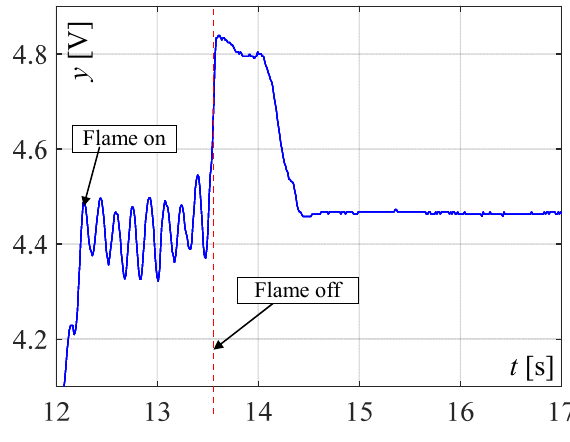
Figure 19. IR diode output signal if the flame is on and off.